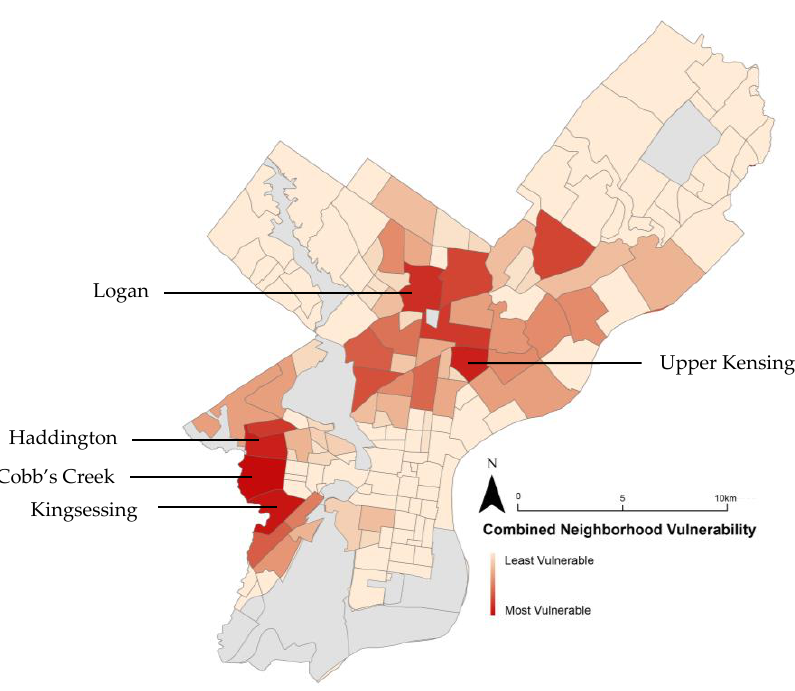
Figure 6. Cumulative vulnerability for heat and street trees by neighborhood. This represents the scores for both heat vulnerability and lack of street trees. Vulnerability scales from 1 to 25 with lightest colors representing least vulnerable and darkest colors representing most vulnerable as compared to other block groups in the study area. Note: the light gray area represents areas of no data.